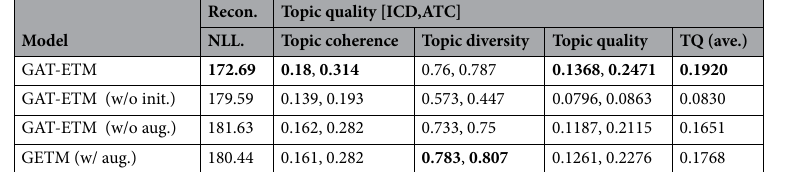
Table 3. Ablation study. The best score for each metric are in [bold].